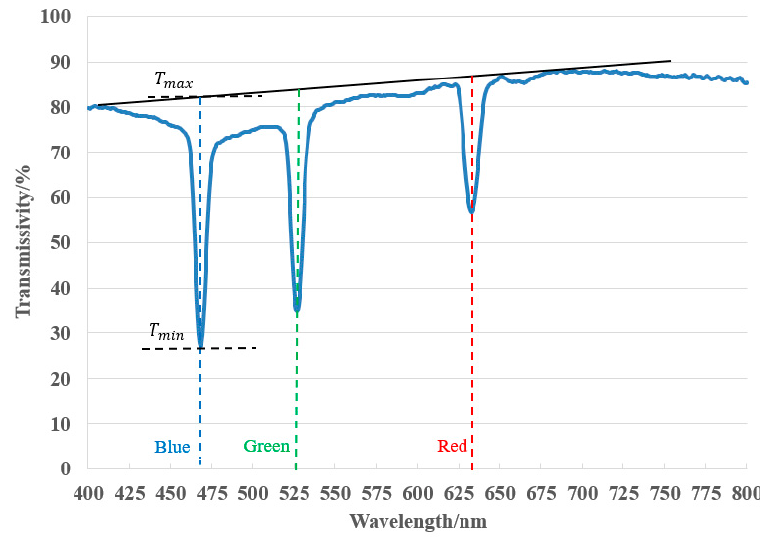
Figure 10. Transmission spectrum of full-color volume holography. It can be seen from Figure 10 that the simultaneous exposure can achieve higher diffraction efficiency. After calculation by Equation (12), diffraction efficiency of 66.81% for recording wavelength in 473 nm, 58.34% for 532 nm and 34.08% for 639 nm were achieved. Blue light has the highest efficiency, followed by green light, and red light has the lowest diffraction efficiency. The diffraction efficiency for both blue and green light exceeds 50%, and good results have been achieved. The diffraction efficiency of red light is relatively